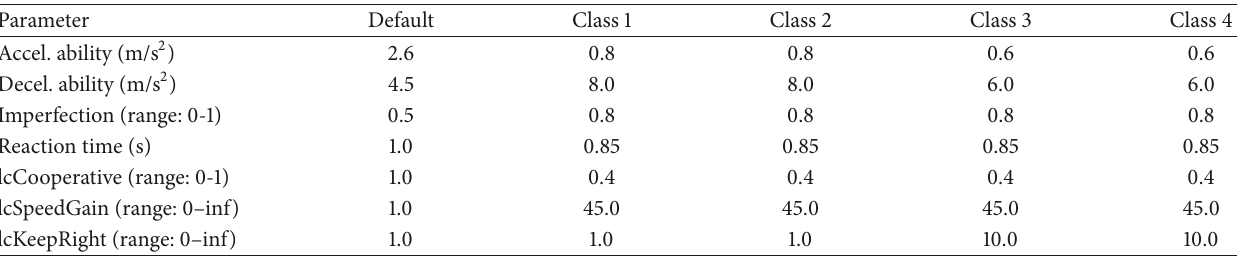
Table 3: Vehicle parameters based on the calibrated